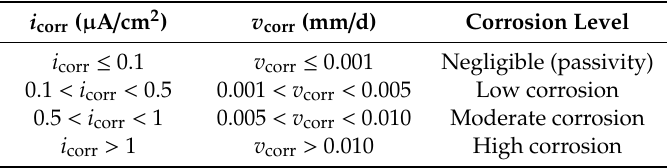
Table 5. Ranges of corrosion current density ( i corr ), and the corrosion rate ( v corr ) related to corrosion level